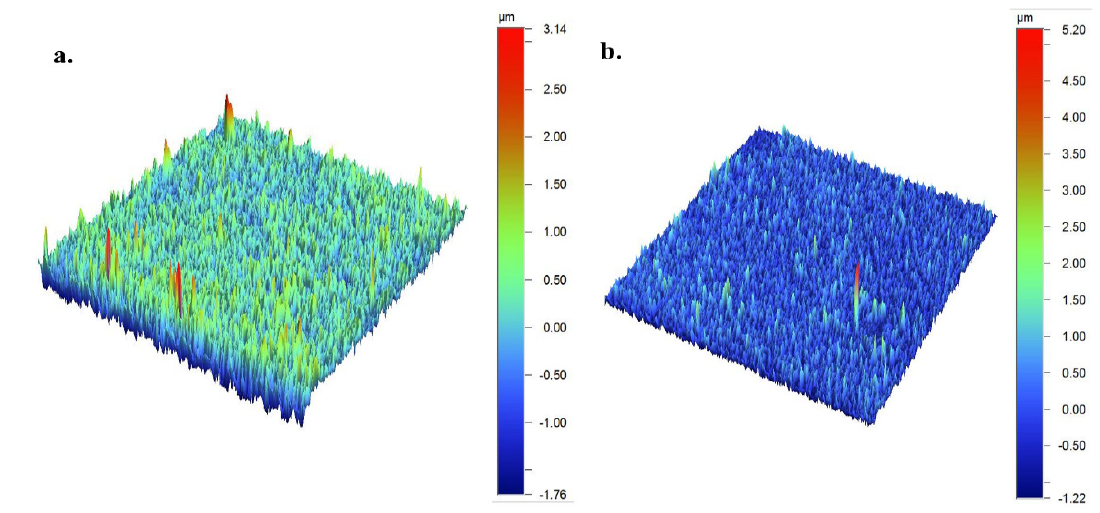
Figure 2. Profilometry images obtained for PEDOT: κ C:Dx films ( a ) before and ( b ) after 160 cycles of cyclic voltammetry in a 0.10 M ammonium acetate solution.